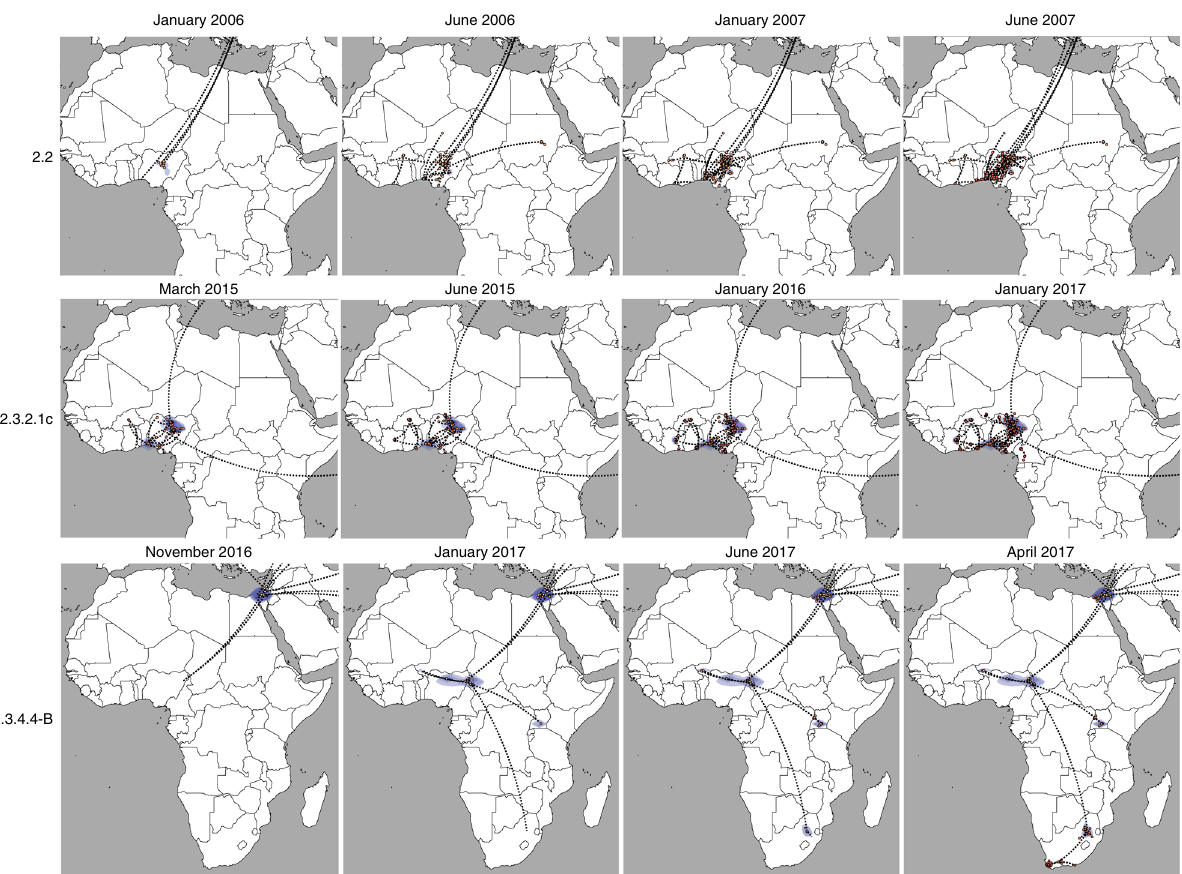
Fig. 5 Spatiotemporal dispersal of the three HPAI H5Nx clades within the African continent. Dispersal patterns of H5Nx viruses in Africa, inferred using continuous phylogeographic analysis, are shown for four time slices for each of the three HPAI H5Nx clades. The black dashed lines and the dots represent part of the branches and the nodes of the MCC tree up to each of the indicated time. Dots are coloured according to the time (from yellow for the oldest to red for the youngest). Contours represent statistical uncertainty of the estimated locations at the internal nodes (95% credible contours based on kernel density